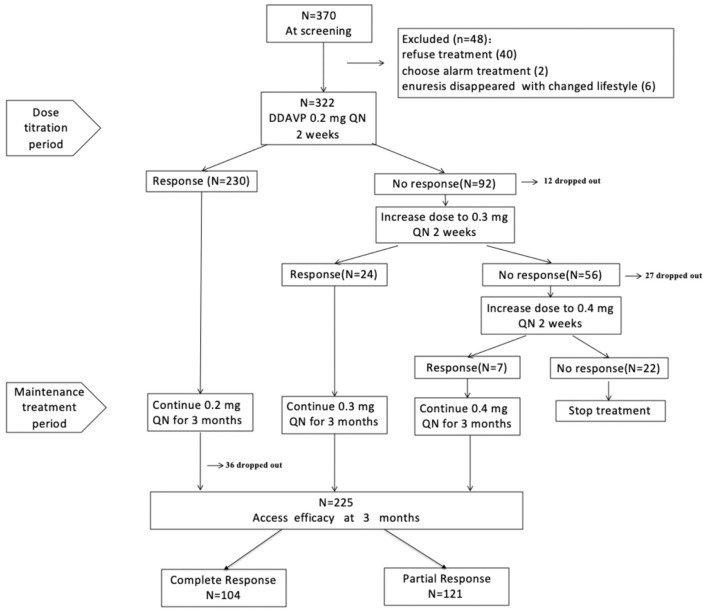
Study flow chart.